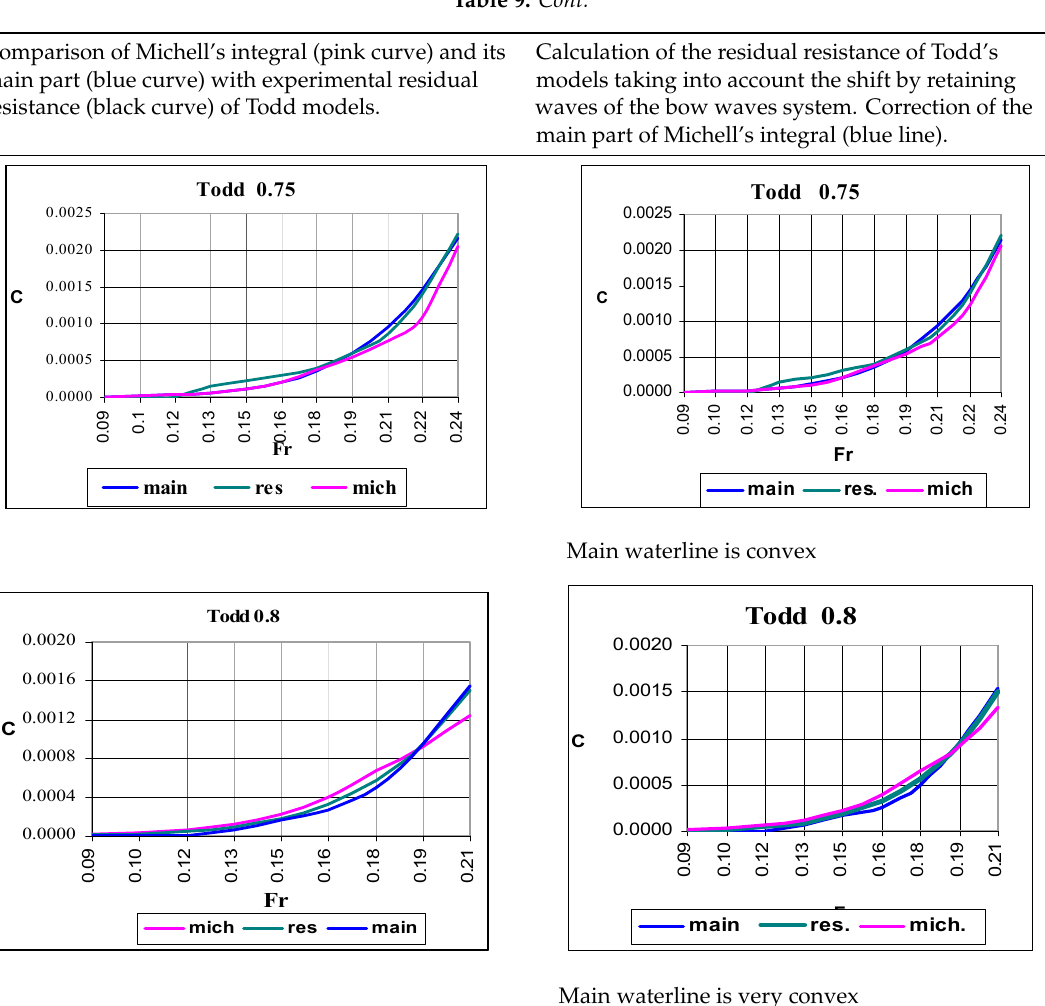
Comparison of Michell’s integral (pink curve) and its main part (blue curve) with experimental residual resistance (black curve) of Todd models.